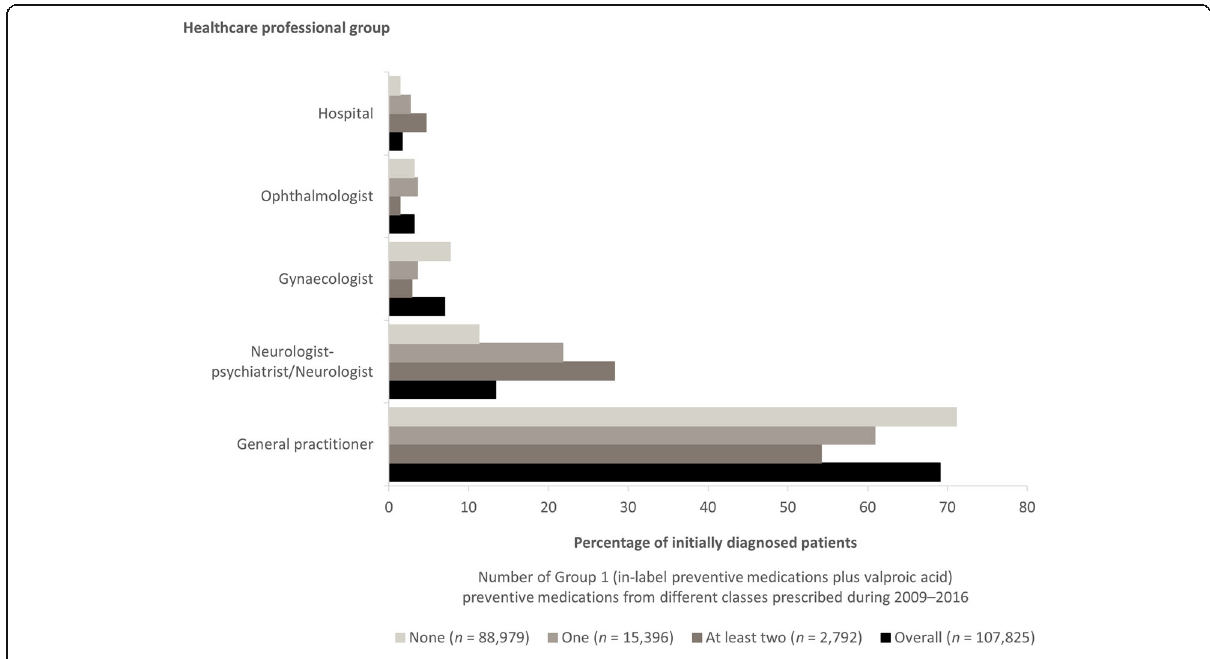
Fig. 7 Healthcare professional group who made the first diagnosis of migraine in the German Company Sickness Fund Database 2009 – 2016. Data are shown for all patients (overall) and patients grouped according to the number of restricted Group 1 (propranolol, metoprolol, flunarizine, topiramate and amitriptyline, but not onabotulinum toxin A or valproic acid) preventive medications from different classes prescribed during 2009 to 2016. Data shown are for healthcare professional groups/hospital with > 1.5% of first visits overall. n number of patients with